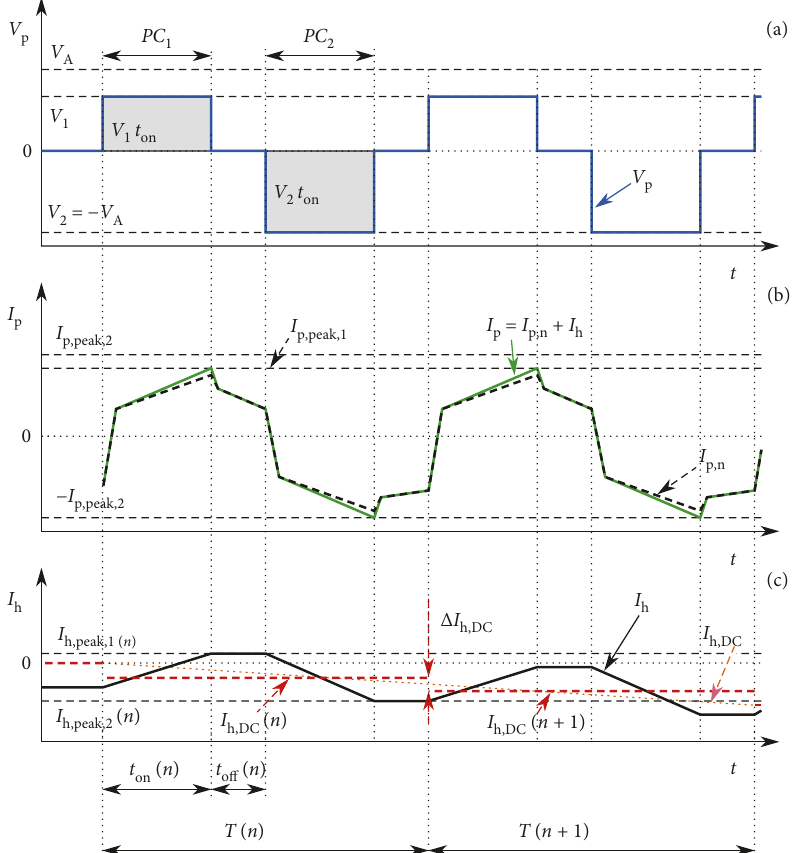
Figure 2: Schematic characteristics of transformer of PSFB with a present flux imbalance. (a) shows the applied primary voltage V explains the according primary current I course of magnetizing current I increases each period T ( n ) till transformer